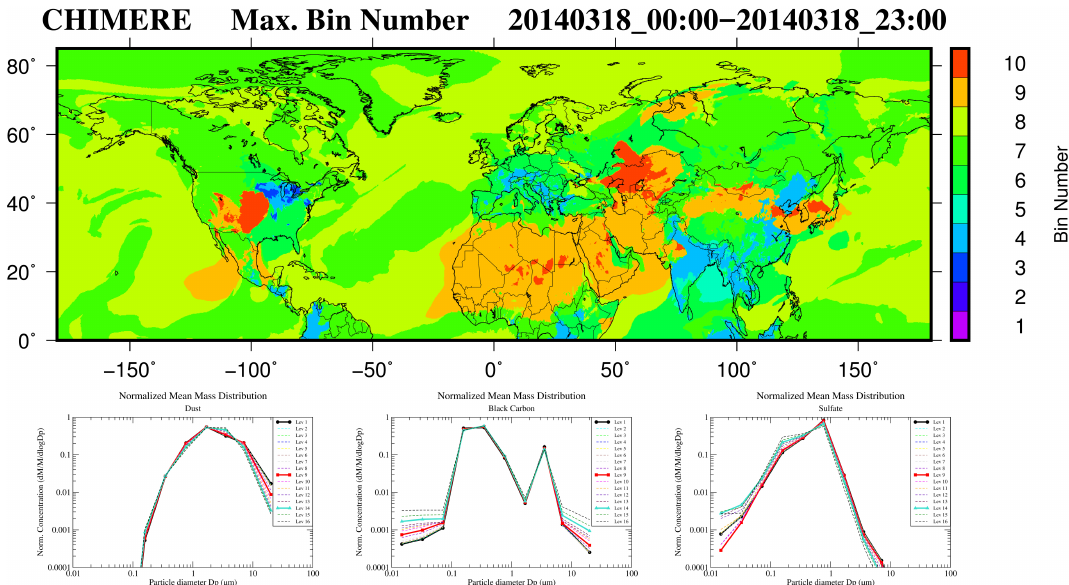
Figure 6. ( Top ) Map of the size bin number corresponding to the maximum surface concentrations for the mean total PM concentrations on 18 March 2014. ( Bottom ) Mean normalized size distributions for dust compared to black carbon and sulfate, averaged over the whole hemispheric domain for each model level [1–16] from the surface to the top on 18 March